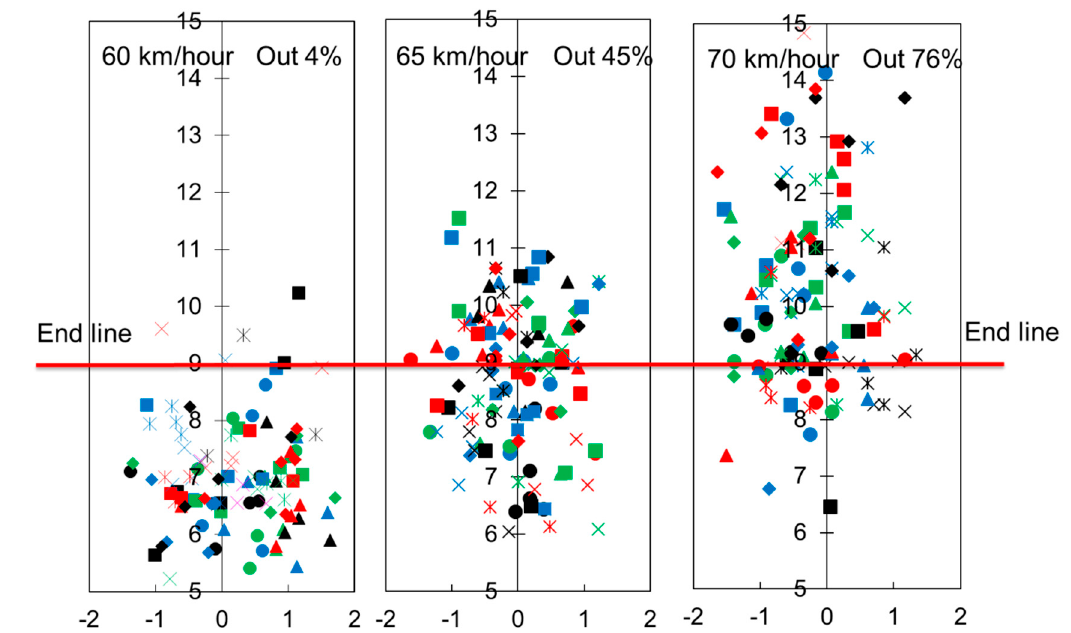
Figure 12. Landing points by different ejection speed on V200W with different panel orientation.